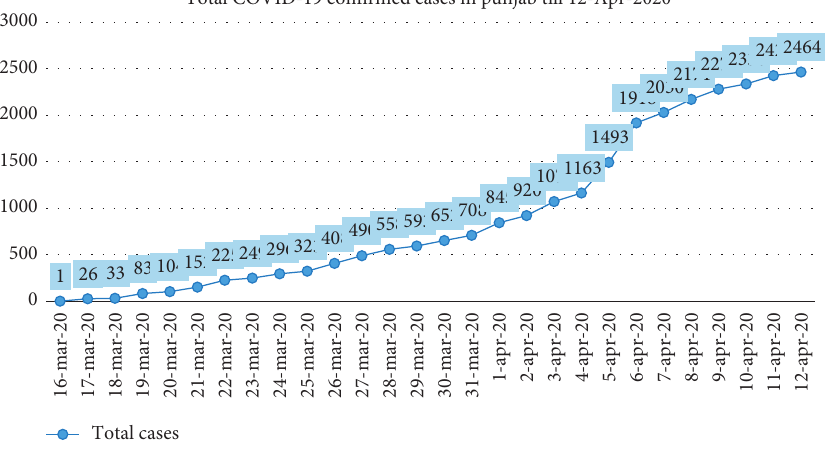
Figure 1: Total COVID-19 confirmed cases in Punjab till 12 Apr 2020.